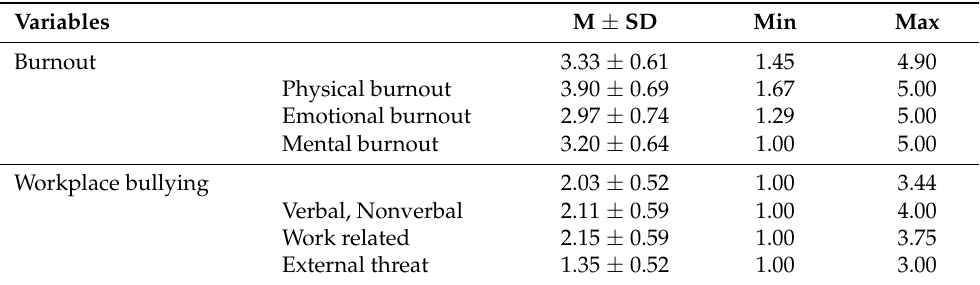
Table 2. The level of burnout, workplace bullying, positive psychological capital, and social support ( n =